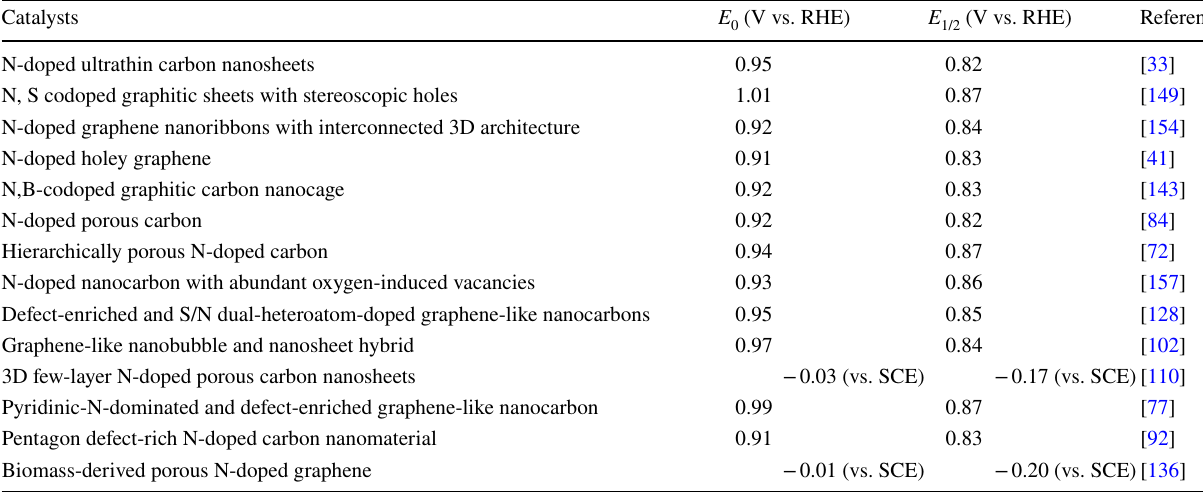
Table 1 Typical defect- and heteroatom doping-co-engineered non-metal nanocarbon electrocatalysts and their key ORR parameters (onset and half-wave potentials,